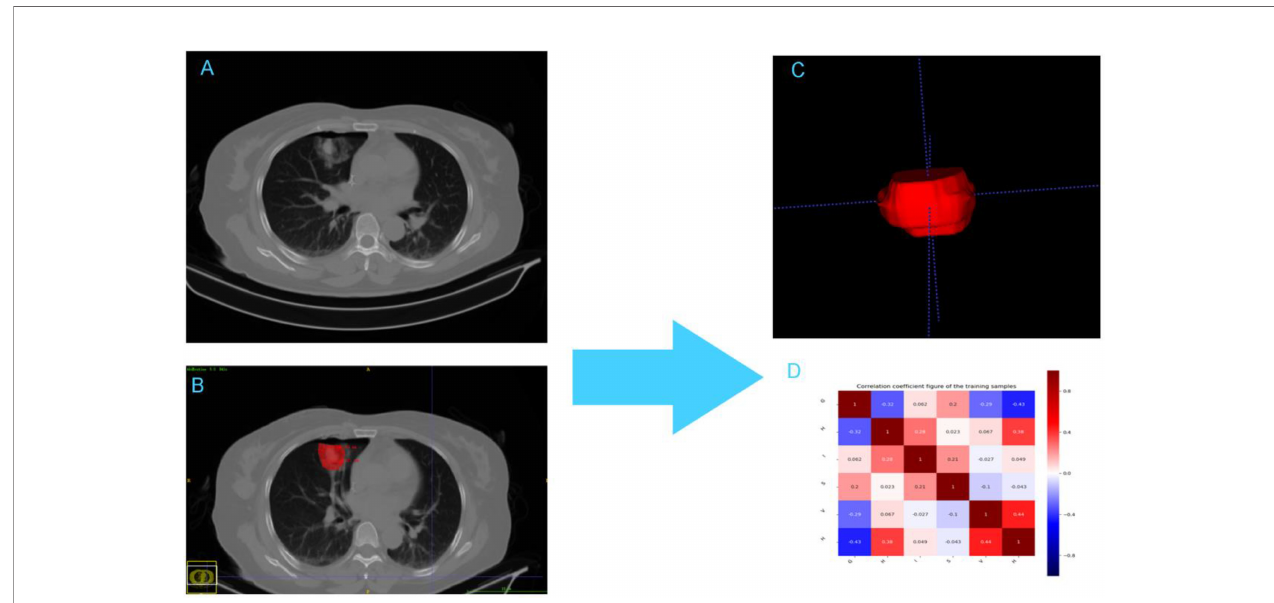
FIGURE 1 | The framework for the radiomic work fl ow. (A) CT acquisition (B) Ablation lesion segmention (C) Feature extraction (D) Heatmap of the correlation of the radiomic